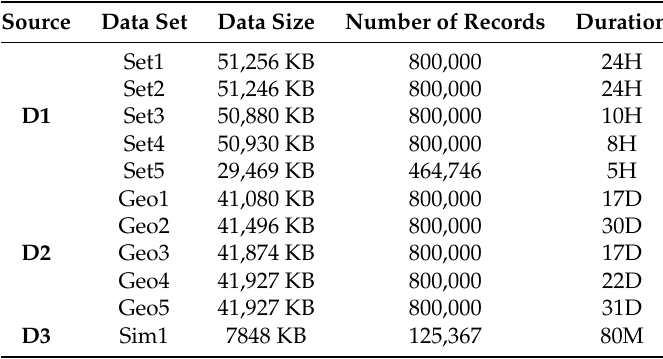
Table 6. Data Sets Information.